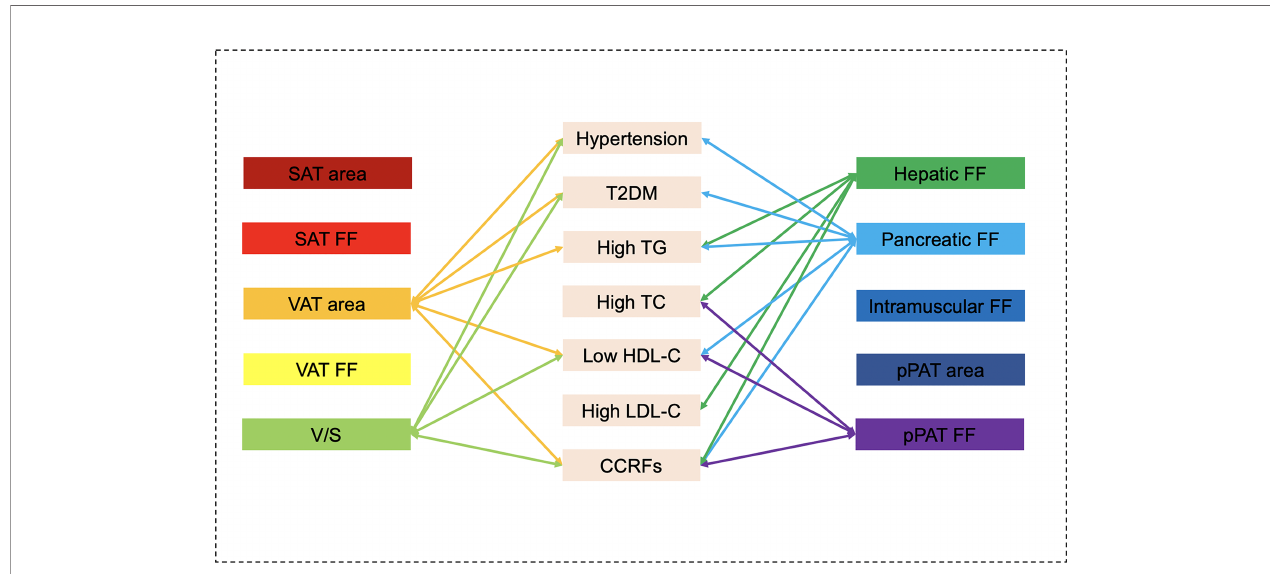
FIGURE 5 | Graphical summary of the important correlates between various MR-acquired fat measurements and dichotomous cardiometabolic risk factors independent of BMI shown in the present study. VAT area, V/S, hepatic fat, pancreatic fat, and pPAT were signi fi cantly associated with multiple dichotomous cardiometabolic risk